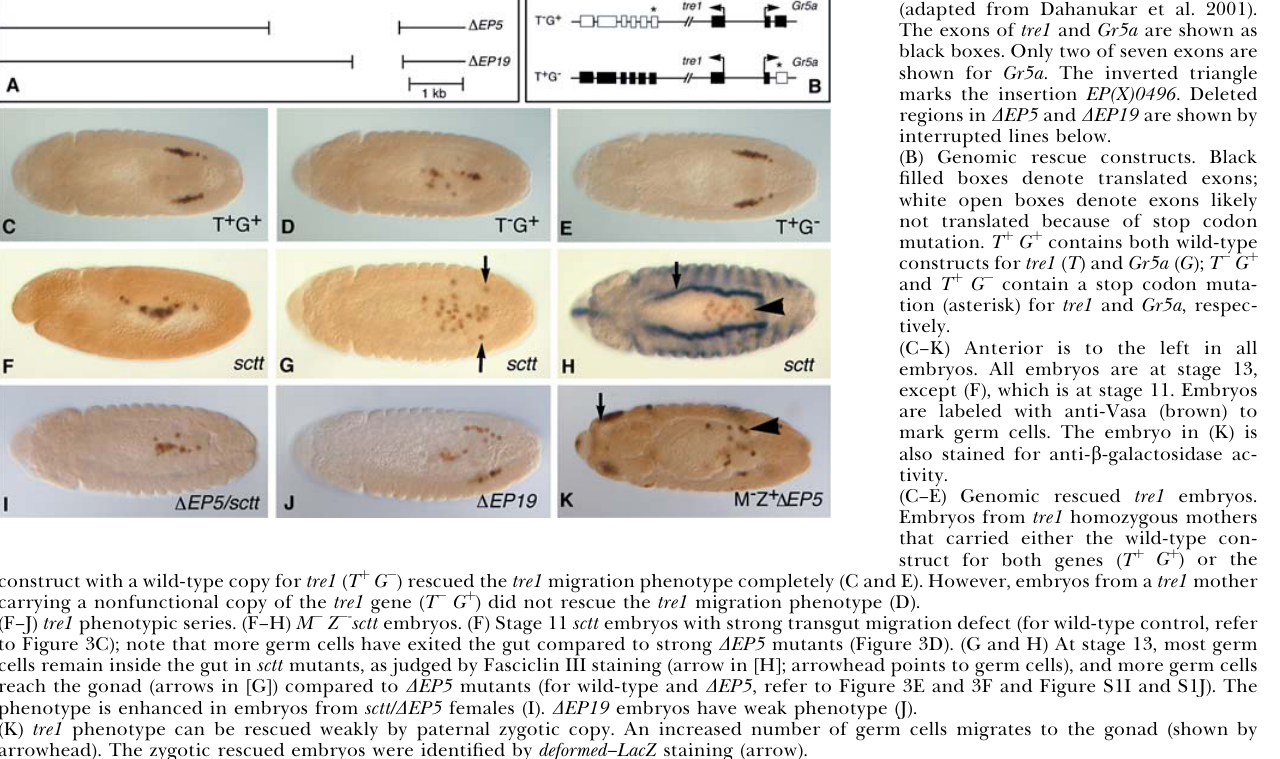
Figure 4. tre1 Gene Structure, Genomic Rescue, and tre1 Phenotypic Series (A) Molecular structure of the tre1 region (adapted from Dahanukar et al. 2001). The exons of tre1 and Gr5a are shown as black boxes. Only two of seven exons are shown for Gr5a . The inverted triangle marks the insertion EP(X)0496 .